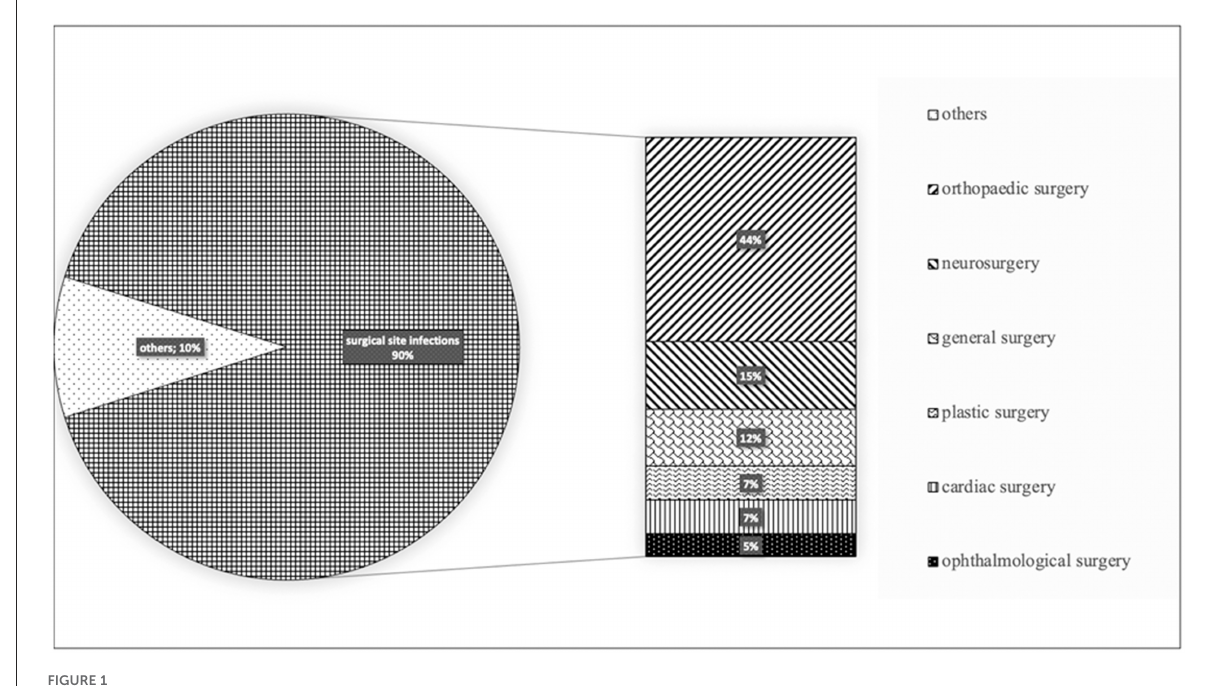
FIGURE1 Types of nosocomial infections divided by hospital wards.